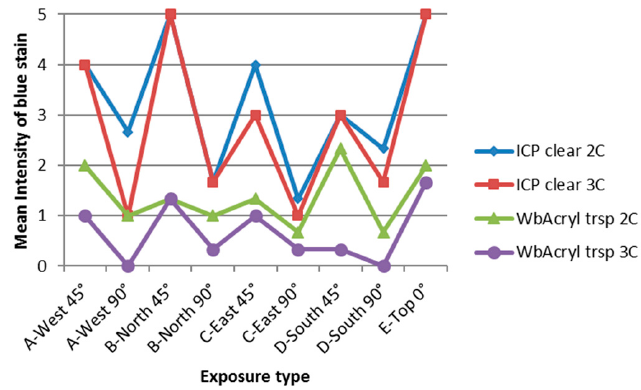
Figure 12. Mean intensity of blue stain after 12 months of exposure (August 2016) using the MFER.